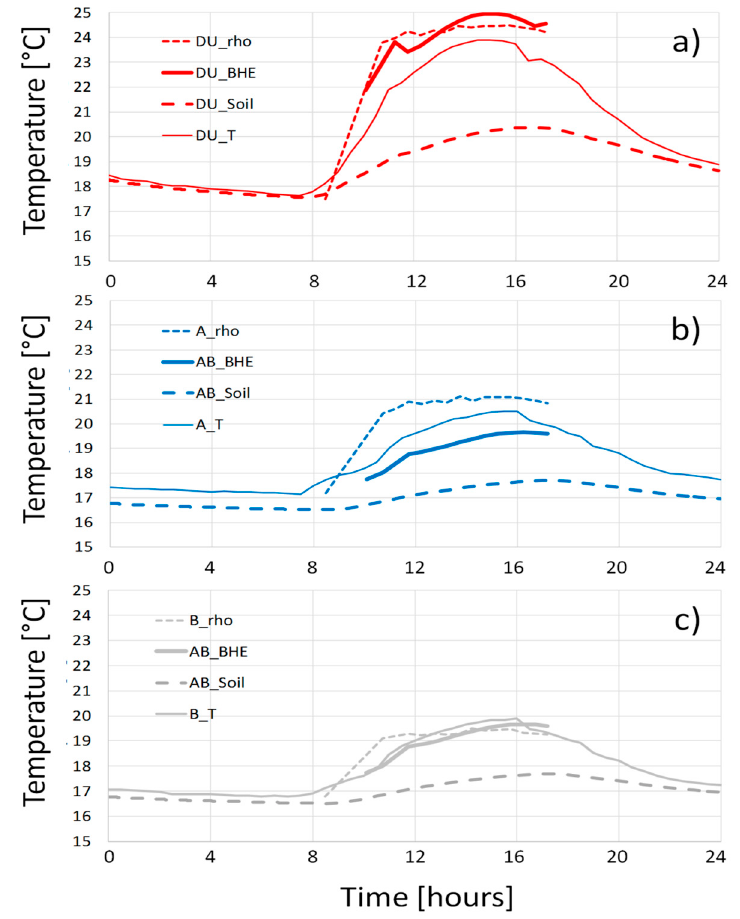
Figure 10. Comparison of the temperatures obtained from: Local direct measurements (continuous lines _T ), numerical simulations (bold lines, inside the BHEs _BHE, dashed lines outside them _Soil ) and inverted resistivity data (Equation (3), dashed lines _rho ) near: ( a ) The central double-U heat exchanger ( DU ) and two of the external single-U heat exchangers, A in ( b ) and B in ( c ), for the whole monitoring day.